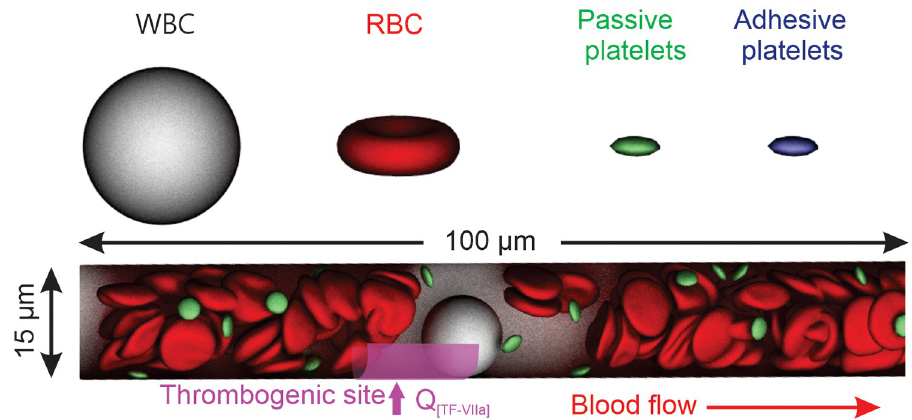
Fig 1. Schematics of the simulation setup. Top row: particle-based models for WBCs, RBCs and platelets. Second row: A 3D circular microchannel with a diameter of 15 μ m and a length of 100 μ m is filled with RBCs, platelets, one WBC and solvent particles which carry 23 factors. Solvent particles and RBCs close to the WBC are omitted in visualization for clarity. One thrombogenic site (highlighted in magenta) with a length of 30 μ m is assigned on the vessel wall. Mass fluxes of four factors (listed in Table C in S3 Text) depending on the level of [TF-VIIa] are injected into the channel from the thrombogenic site to initiate and drive the coagulation cascade. Blood flows from left to